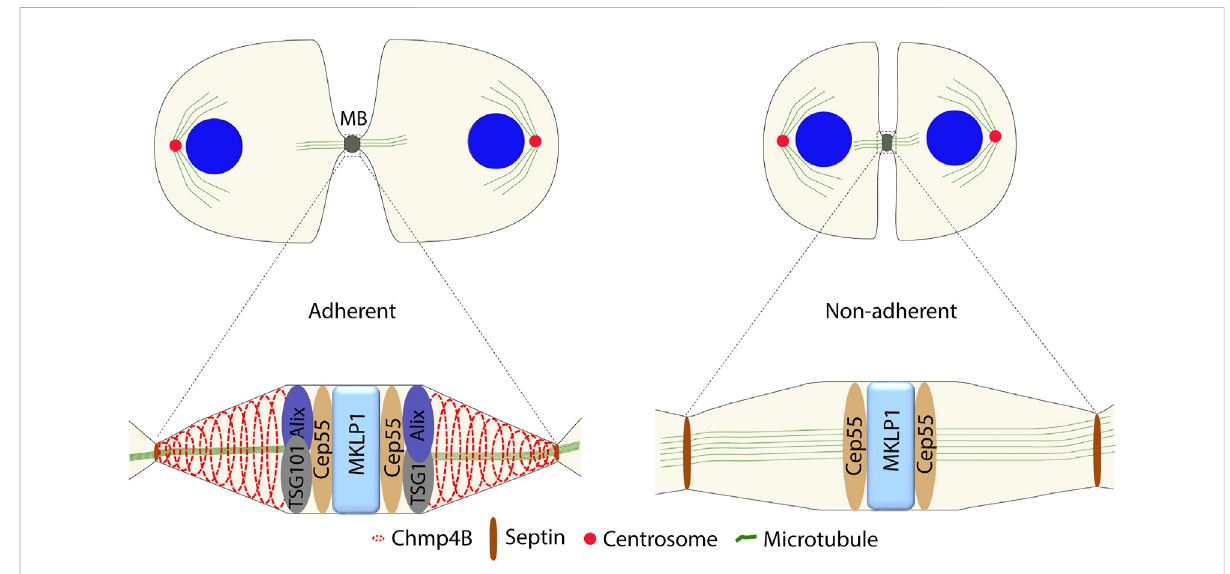
FIGURE 2 Difference in the protein composition at the MB between the adherent and non-adherent cells during